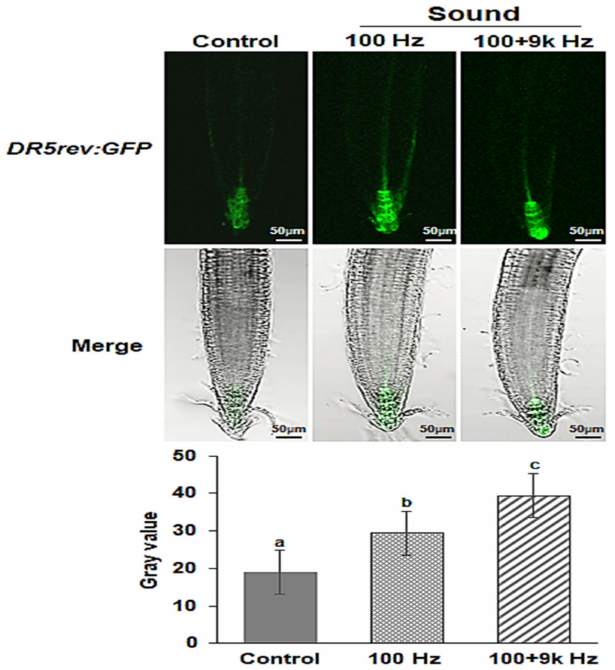
Figure 7. The expression profile of the auxin-specific reporter gene DR5 as green fluorescence in Arabidopsis roots exposed to sound wave treatments using confocal microscopy. Images show representative individuals of at least 20 seedlings in three replicate experiments. Scale bars represent 50 µ m. Different letters above the bars indicate significantly different mean values ( p < 0.05) based on Duncan’s multiple range